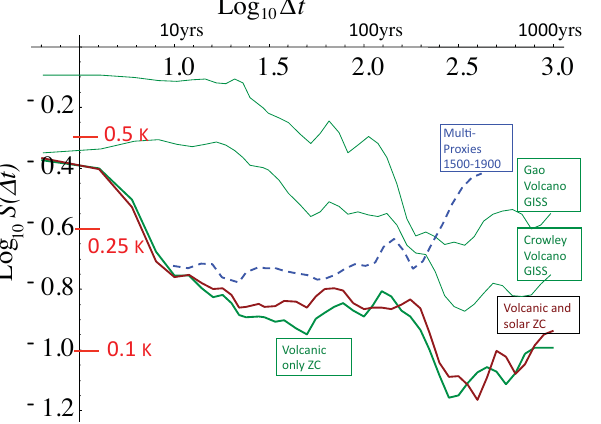
Figure 5. A comparison of the volcanic forcings for the ZC model (bottom, green) and for the GISS-E2-R GCM for two different vol- canic reconstructions (Gao et al., 2008; Crowley, 2000) (top green curves, reproduced from Lovejoy et al., 2013). Also shown is the combined response (ZC, brown) and the pre-industrial multiproxies (dashed